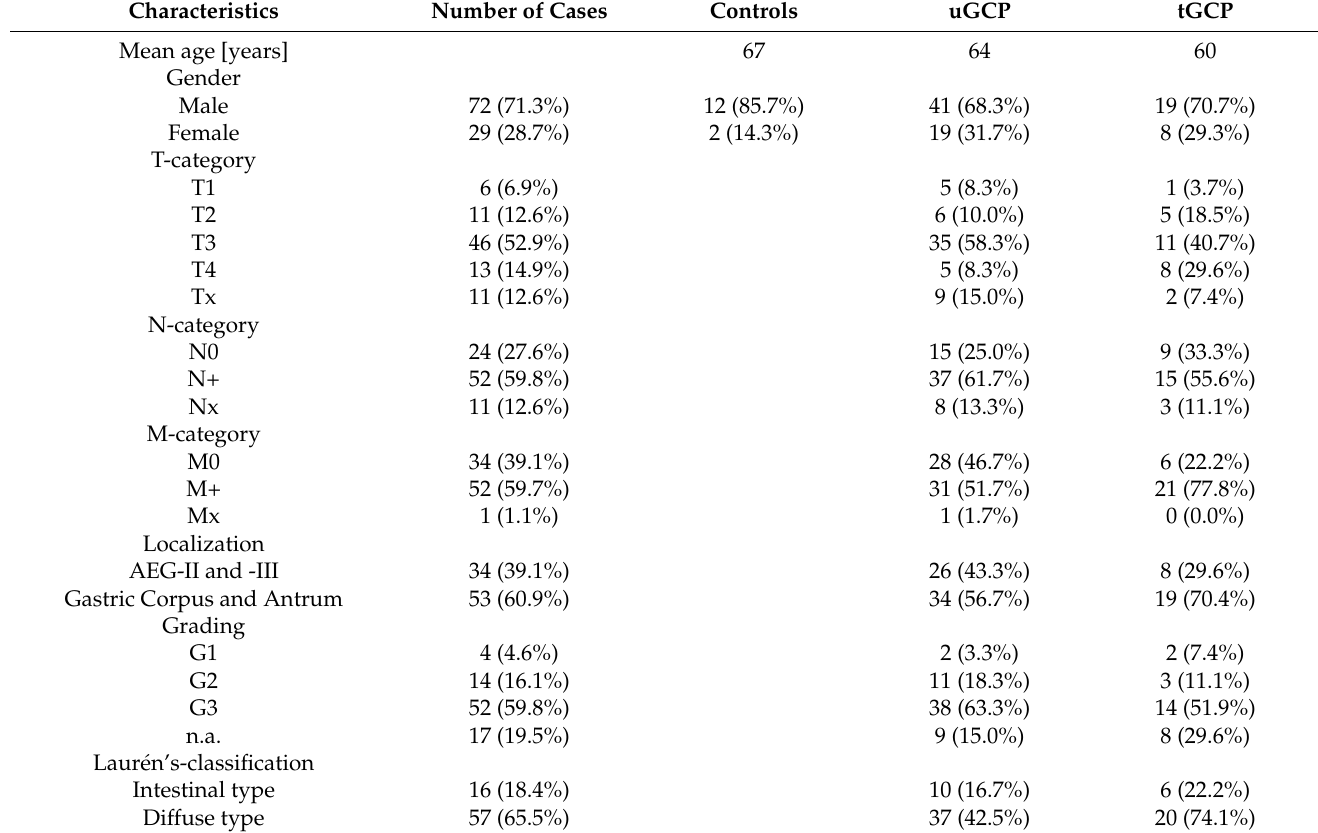
Table 2. Clinico-pathological patients’